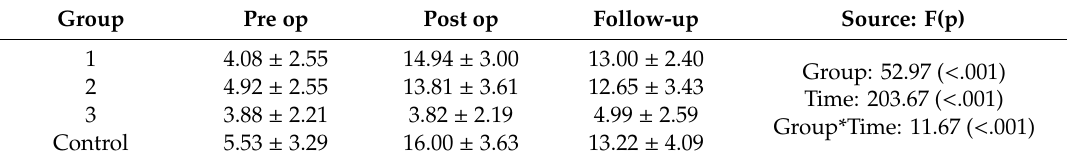
Table 3. Bone height from crestal bone at the planned implant placement site (mm).